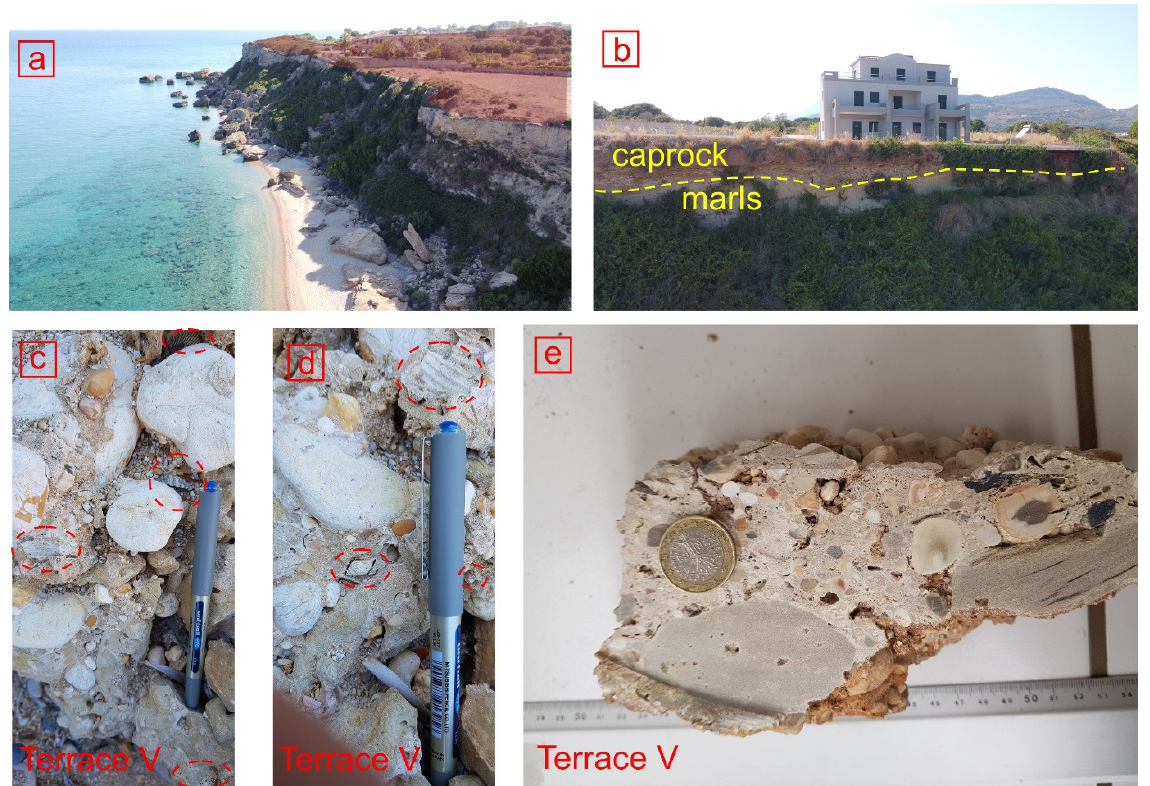
Figure 7. ( a ) Terrace V exposure (view SSW). The red transparent polygon represents the palaeosur- face. The outer edge of the palaeosurface corresponds to the modern sea cliff. ( b ) Same location exposure of terrace V (view W), carved on Pliocene marls, unconformably underlying a caprock formation (contact represented with a yellow dashed line). ( c – e ) Close-up of the caprock formation consisting of well-cemented coarse sand, grit with well-rounded pebbles of limestone composition (1.5–6 cm in diameter). Red dashed circles represent frequent bivalves, bivalve fragments and gas- tropods.